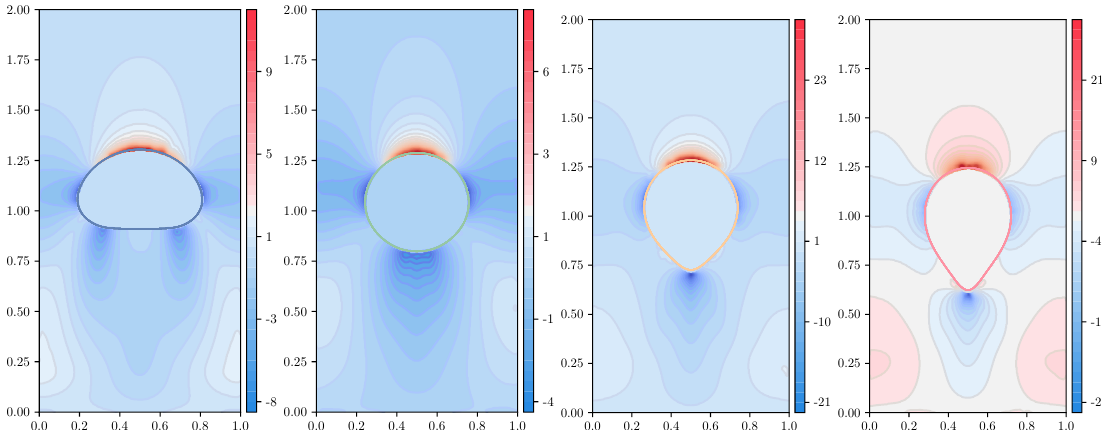
Figure 13. Drop shape and isocontours of normal stress difference of the polymer τ p ,11 − τ p ,22 for the FENE model ( b = 50) with ρ 2 / ρ 1 = 10 − 1 = µ 2 / µ 1 , at t = 3. From left to right, c = 1, De = 1; c = 3, De = 1; c = 5, De = 3; and c = 9, De = 5.